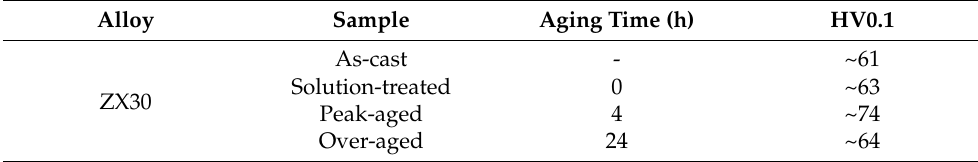
Table 2. Conditions tested with the aging time and Vickers microhardness.